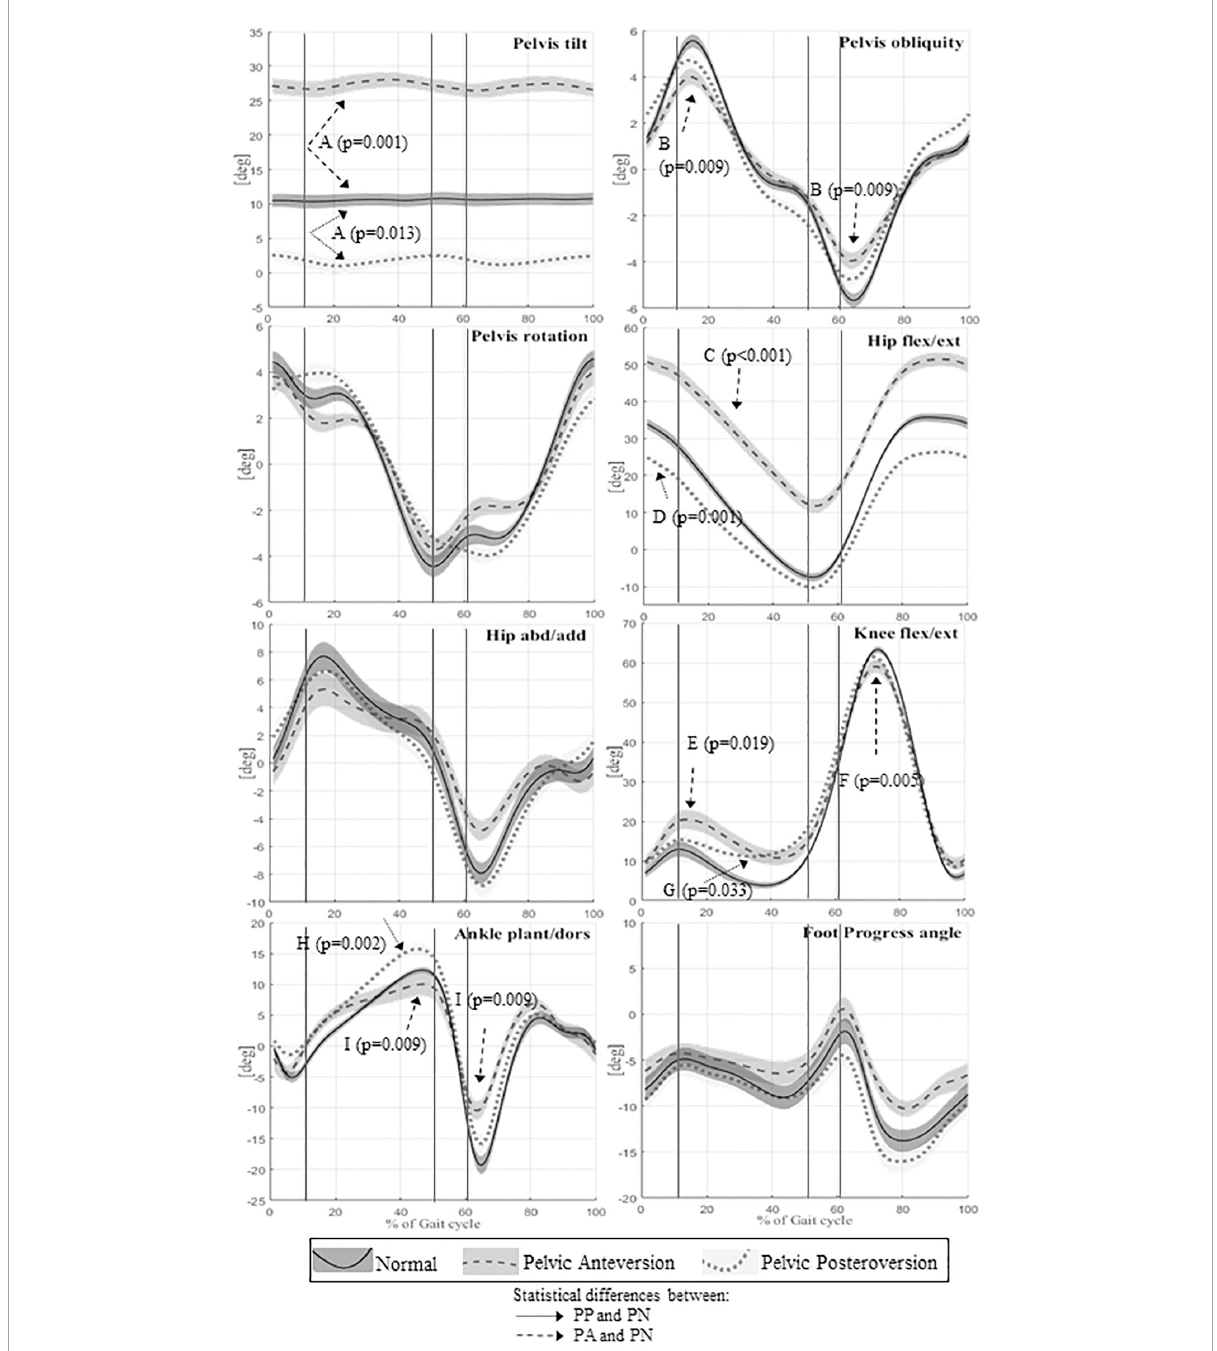
FIGURE2 Means and standard deviation of kinematics angles of lower limb joint movements on the sagittal plane of the whole sample; the angles of the pelvic tilt, rotation and obliquity; the angles on frontal plane of hip and ankle. The angles of joint rotation in degrees are reported on the vertical axis, the time of the gait cycle in percentage is reported on the horizontal axis. Continuous lines represent averaged group value of Normal gait (PN), dashed lines represent averaged group value of Pelvic Anteversion gait (PA), dotted lines represent averaged group value of Pelvic Posteroversion gait (PP). The shaded areas denote the standard deviation (SD), dark gray, normal gray, and light gray stand respectively for Normal, Anteversion, and Posteroversion. The three lines separate the first double support phase (first line), the single support phase (second line), and the second double support phase (third line). Dashed arrows represent statistical differences between PA and PN, dotted arrows represent statistical differences between PP and PN. A (Pelvis tilt mean), B (Pelvis obliquity RoM), C (Hip flexion/extension mean), D (Hip flexion/extension IC), E (Knee max flexion in stance), F (Knee flexion/extension RoM), G (Knee max extension in stance), H (Ankle max dorsiflexion instance), I (Ankle flexion/extension